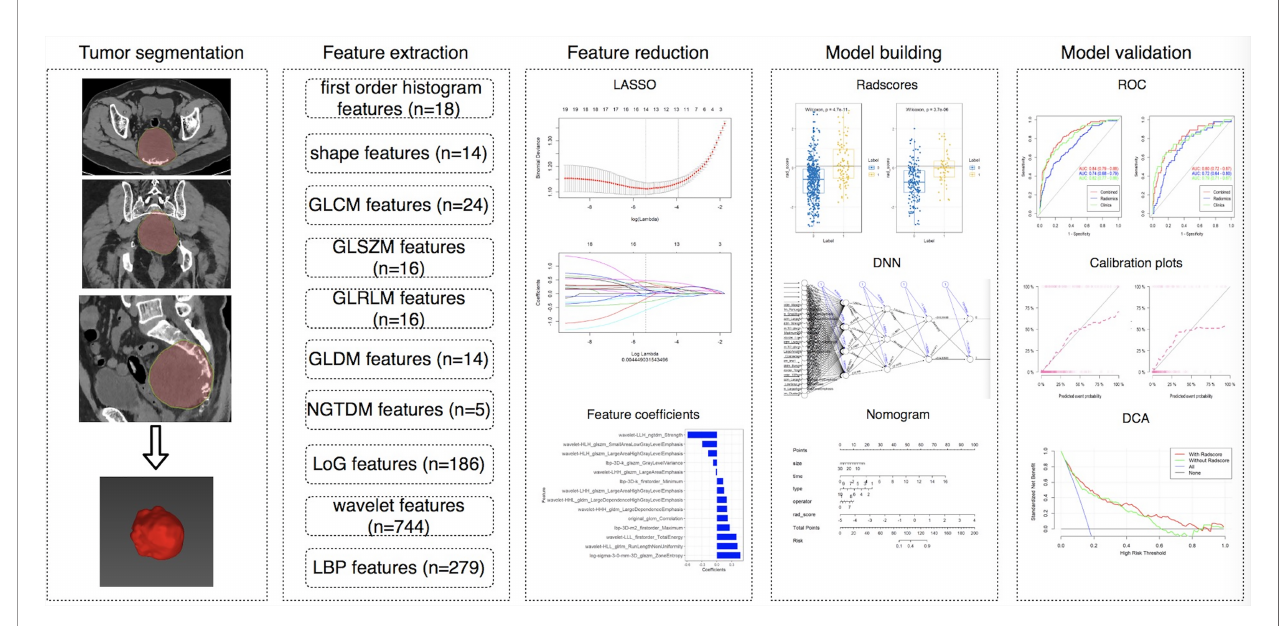
FIGURE 1 | The work fl ow of this